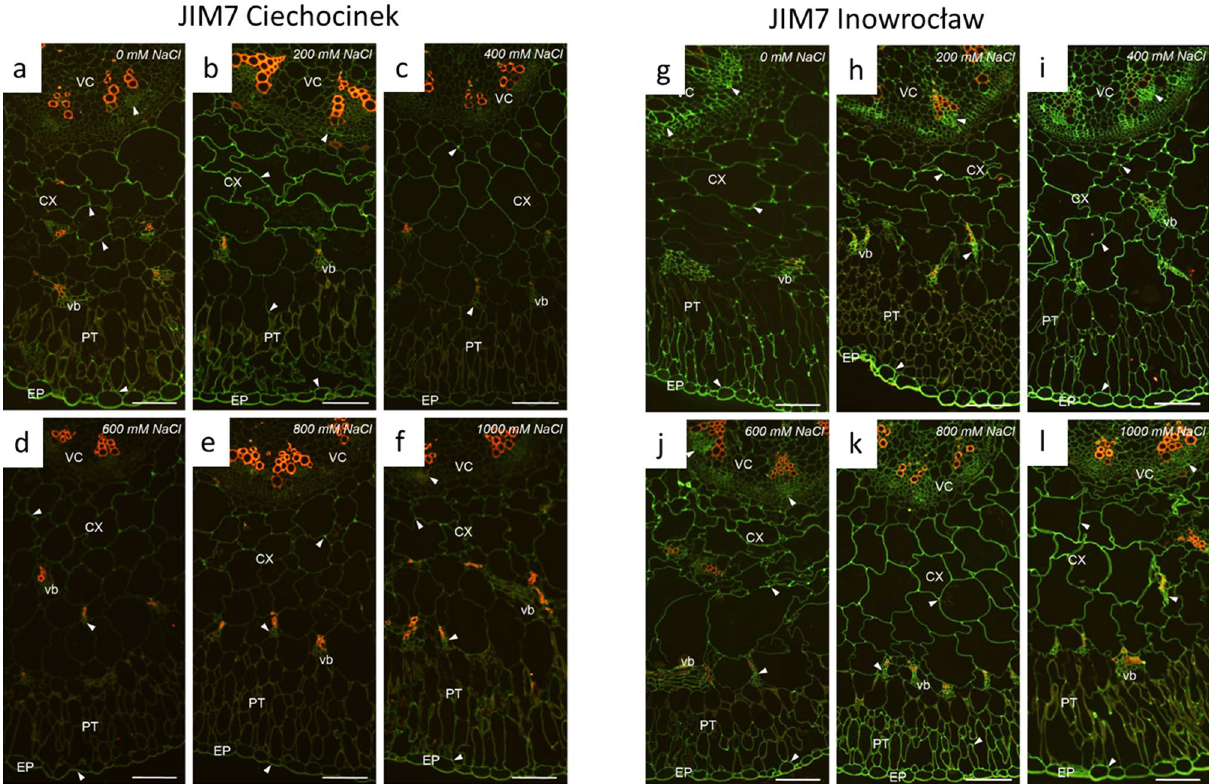
Figure 5. Immunofluorescence localization (arrowheads) of high methylesterified homogalacturonans (HM-HGs) under NaCl stress of two S. europaea populations. ( a – f ) Ciechocinek and ( g – l ) Inowrocław. EP epidermis, PT palisade tissue, CX cortex, vb vascular bundle, VC vascular cylinder. Scale bar 100